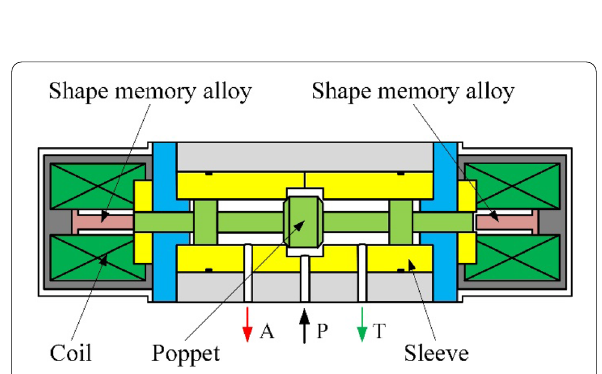
Figure 20 Poppet valve with shape memory alloy proposed by Qin et al.